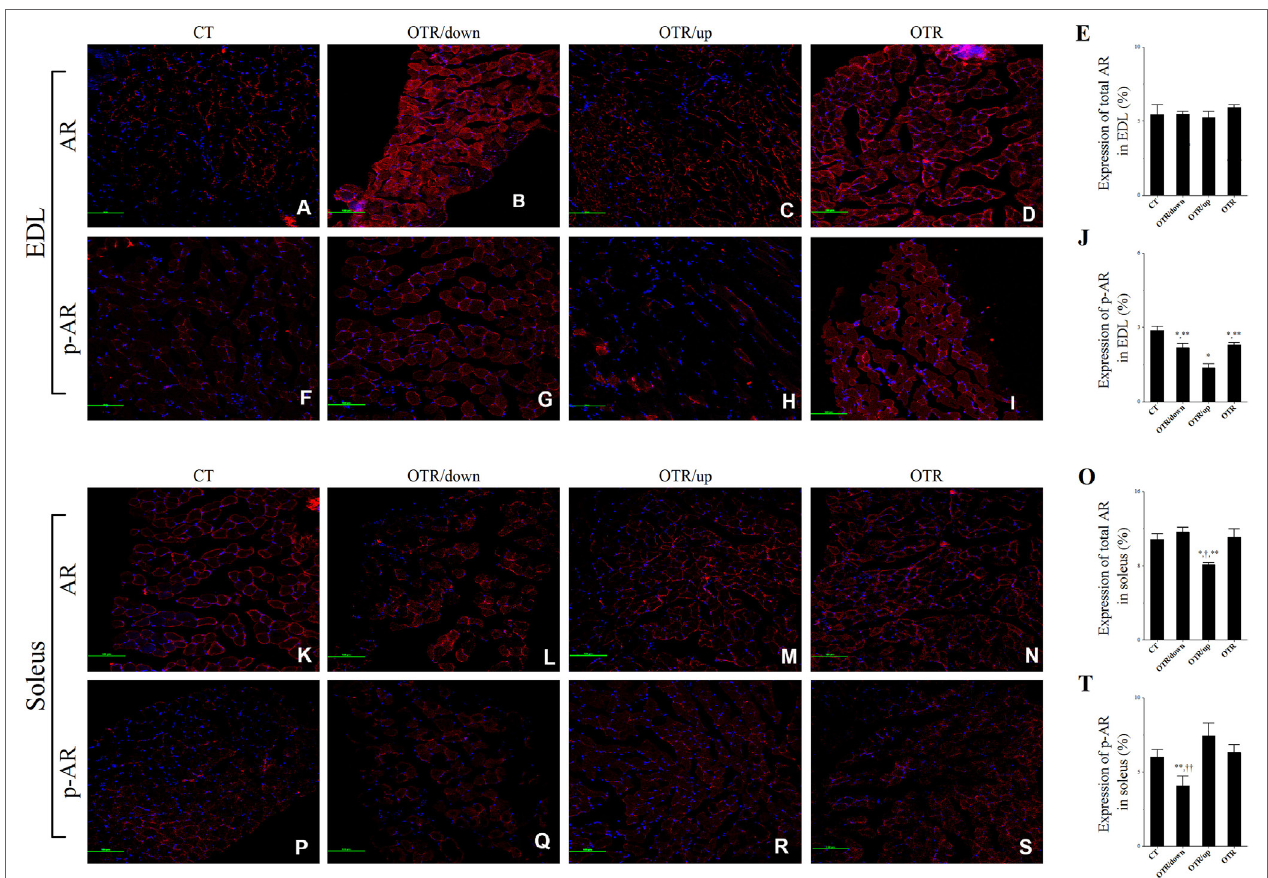
FigUre 6 | Representative immunofluorescence images of total and phosphorylated androgen receptor (AR) expressions in extensor digitorum longus (EDL) and soleus from control (CT) (a,F,K,P) , downhill running-based overtraining (OTR/down) (B,g,l,Q) , OTR/up (c,h,M,r) , and OTR (D,i,n,s) . Percentage of total and phosphorylated AR expressions in EDL (e,J) and soleus (O,T) muscles. Data correspond to n = 4 mice. CT: sedentary mice. OTR/down: overtrained by downhill running. OTR/up: overtrained by uphill running. OTR: overtrained by running without inclination. * P < 0.05 vs. CT; † P < 0.05 vs. OTR/down; ** P < 0.05 vs. OTR/up; †† P < 0.05 vs.